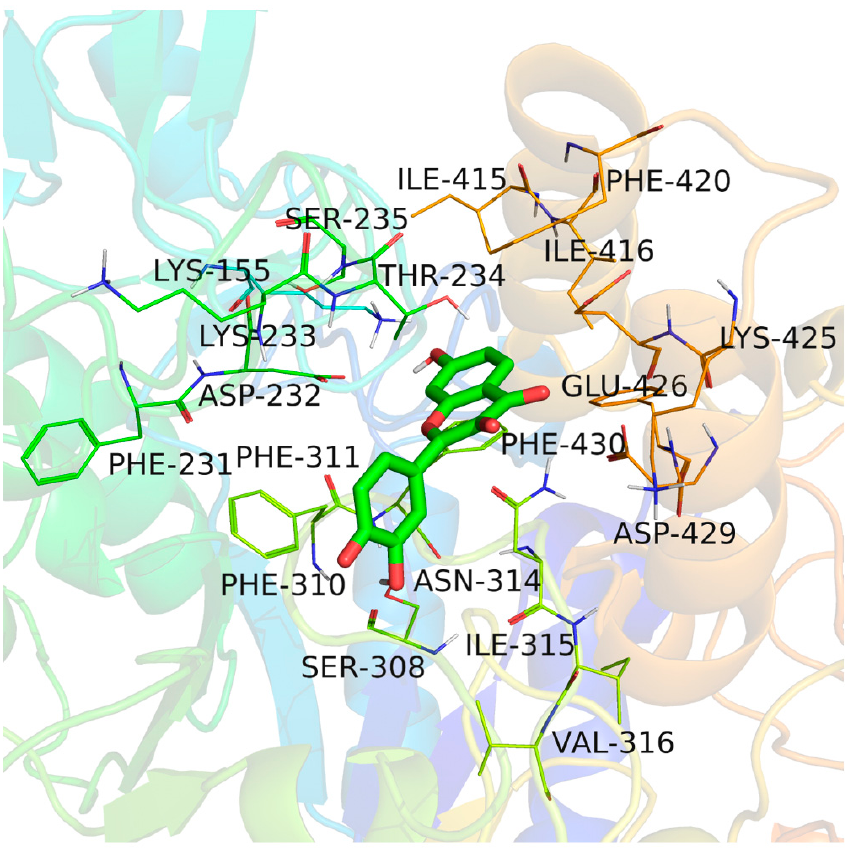
Figure 7. 3 ‐ D interaction between fisetin and α‐ glucosidase.